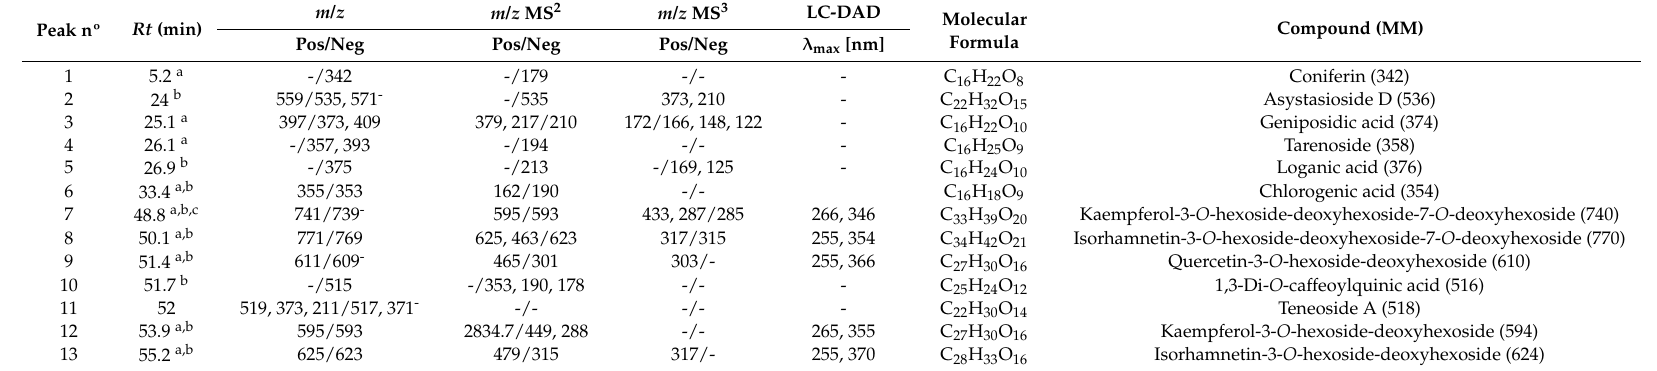
Table 1. Phytochemical profile of leaf extract from G. americana obtained by HPLC-IT-ESI-MS/MS. For conditions, please see Section